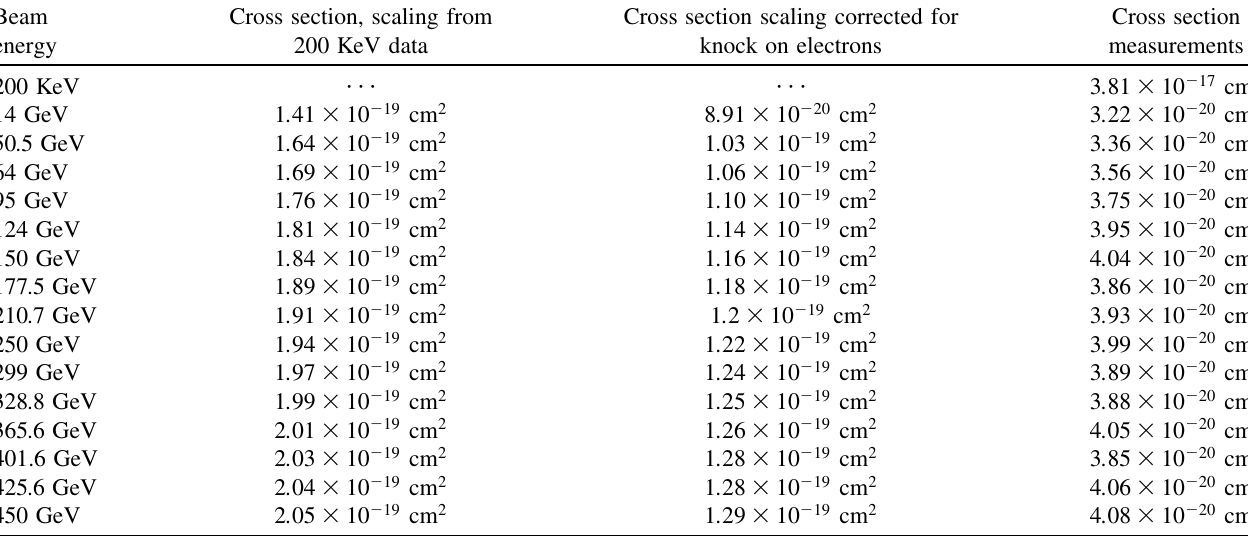
TABLE II. Cross section as a function of the beam energy: Bethe-Bloch scaling from [4] in column 1, corrected for the knock on electrons in column 2, and measurement results in column 3.